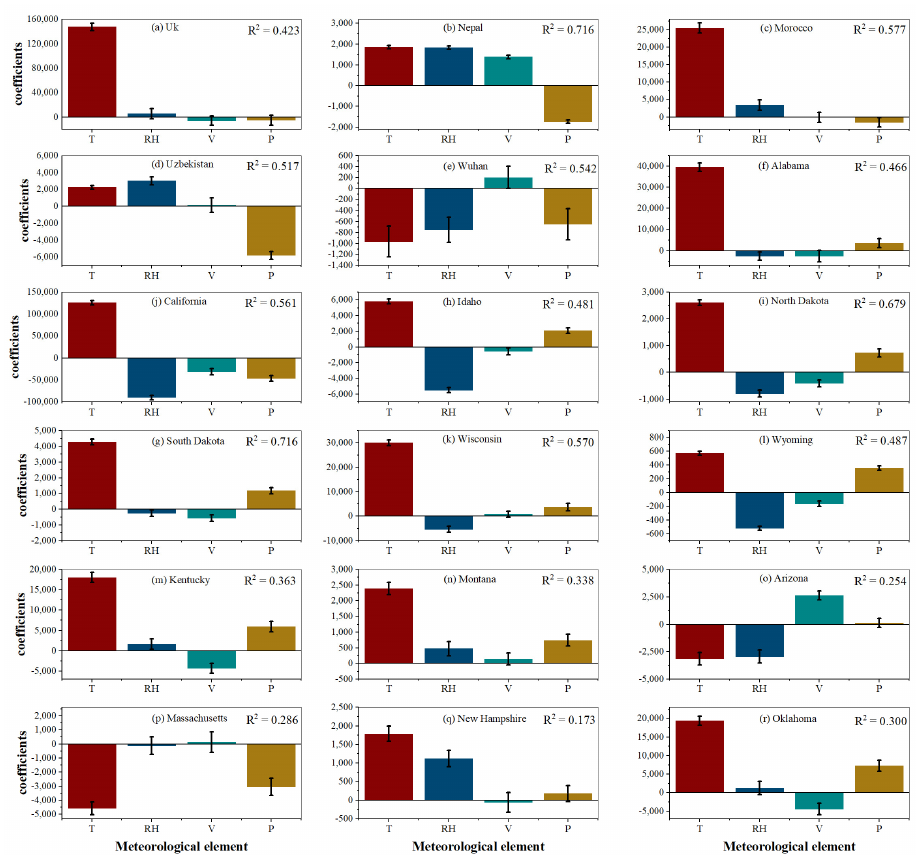
Figure 4. Figures ( a – r ) represents the standardized coefficients of the PLSR for different countries and regions and their significance intervals at 5% confidence